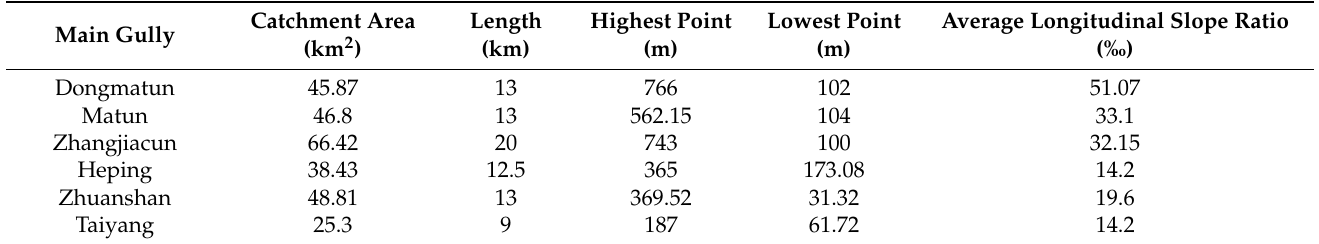
Table 1. Characteristic parameters of six main gullies.